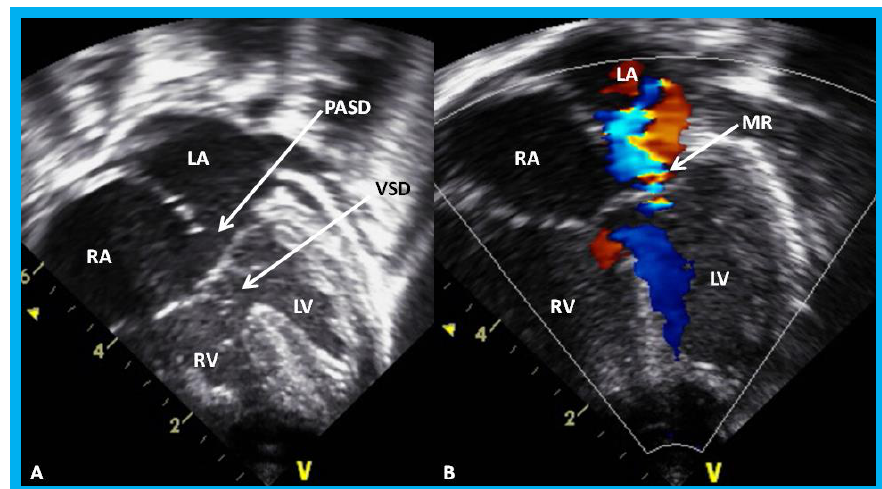
Figure 29. Apical four-chamber view of the heart in baby with Down syndrome demonstrating atrioventricular septal defect in 2D ( A ) and color-Doppler imaging ( B ): Ostium primum atrial septal defect (PASD) and ventricular septal defect (VSD) are shown (arrows) in A and mitral regurgitation (MR) in B (arrow). LA, left atrium; LV, left ventricle; RA, right atrium; RV, right ventricle.